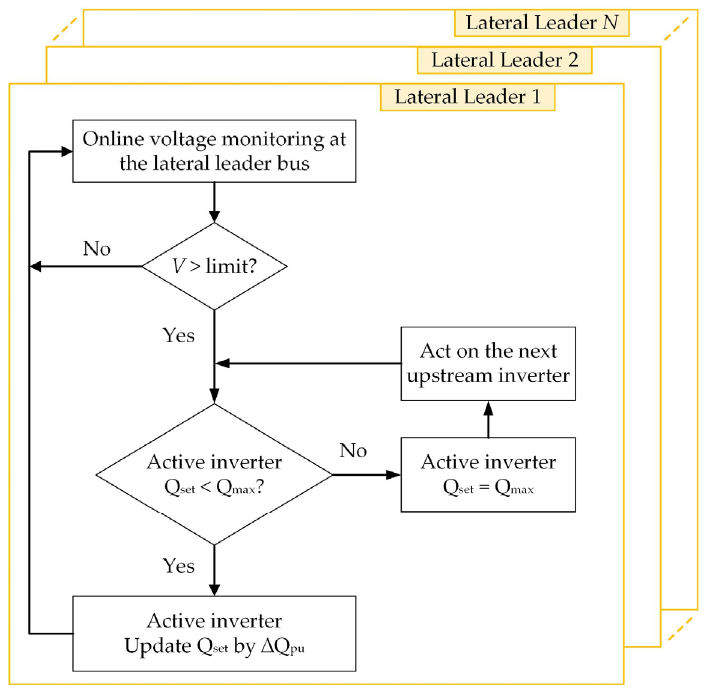
Figure 4. Sequential operation of the lateral leader.